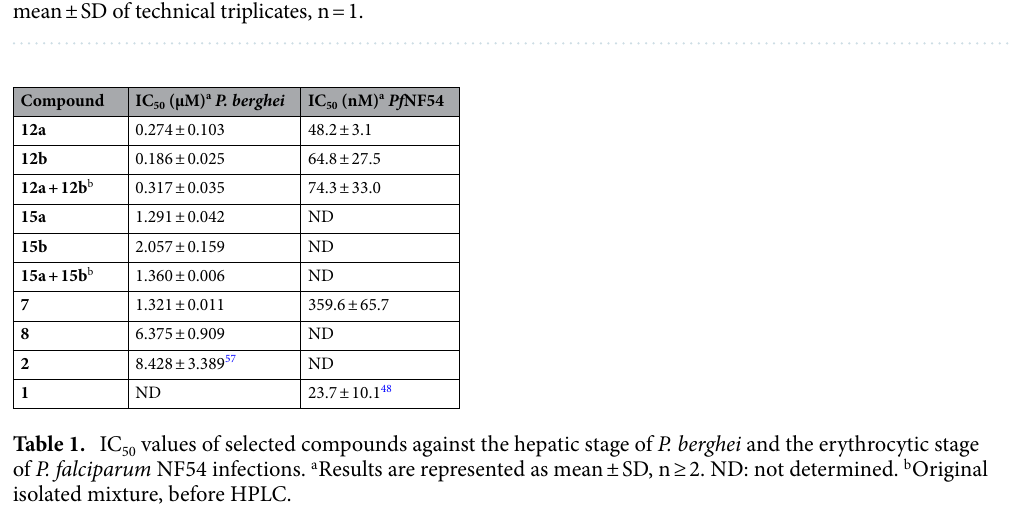
Figure 9. Assessment of in vitro activity of compounds against the hepatic stage of P. berghei infection. Total parasite load (infection scale, bars) and cell viability (cell confluency scale, dots) are shown. Results were normalized to the negative control, the drug vehicle dimethyl sulphoxide (DMSO), and are represented as mean ± SD of technical triplicates, n = 1.